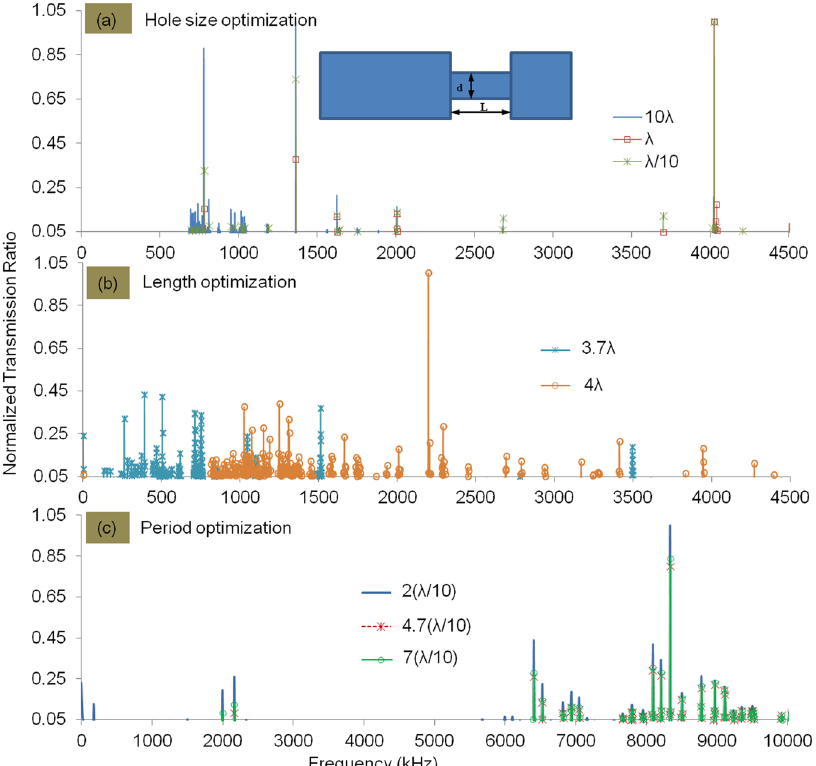
Figure 1. FE results for Transmission Ratio (TR) of metamaterial with varying geometrical parameters of metamaterial lens, for different values of ( a ) Hole size ( b ) Hole length and ( c ) Periodicity (To avoid crowding of data points, for all above graphs the starting value on the ordinate is considered as 0.05 instead of 0). A full set of results is presented in Supplementary Figure 3 in Additional